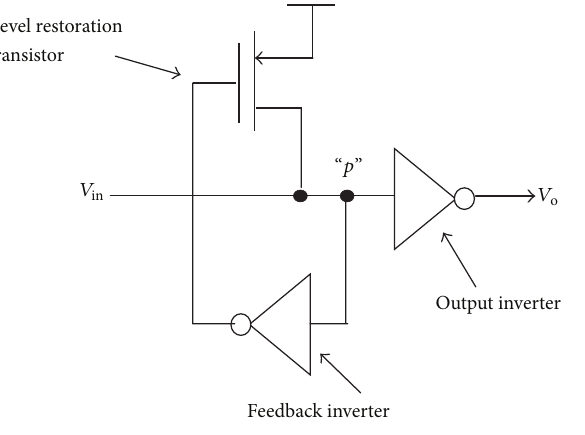
Figure 3: CPTL inverter.